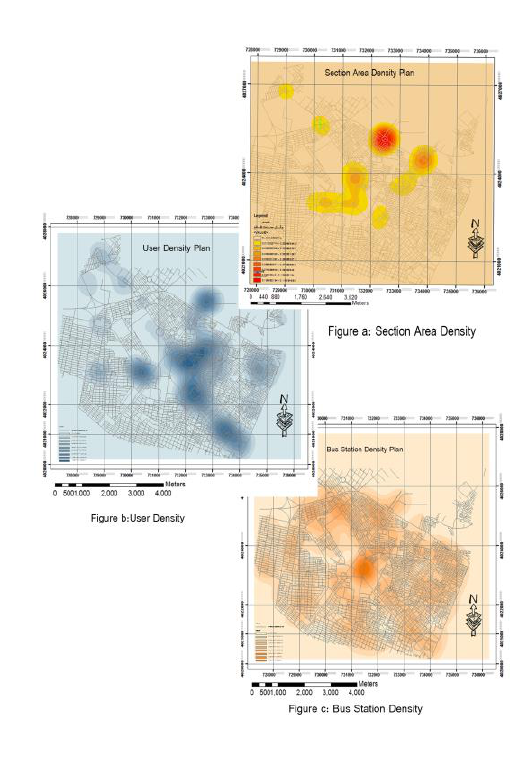
figure. 3 factors prepared in accident